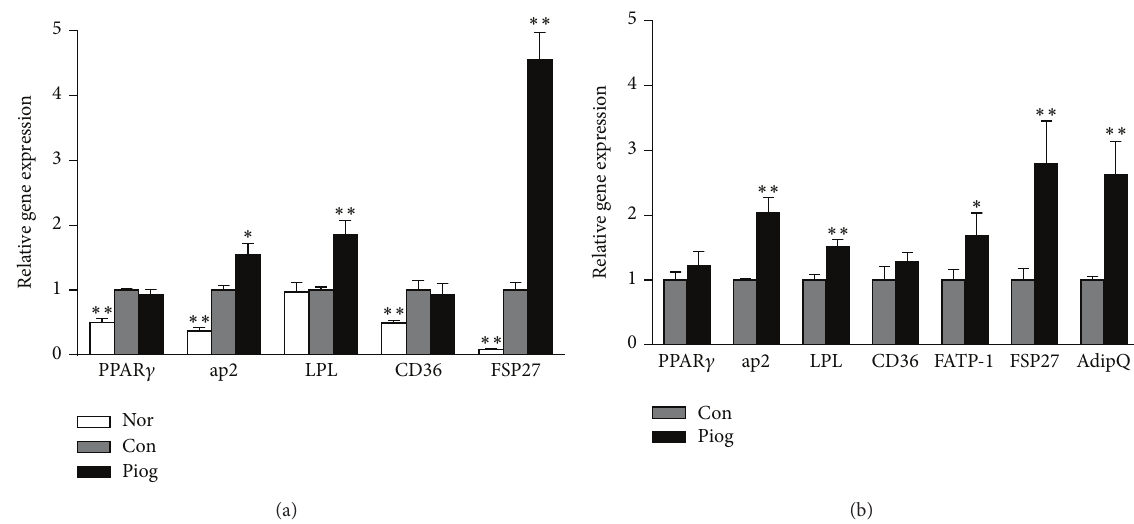
Figure 4: Expression of adipocyte-specific genes in the liver and WAT of vehicle- and pioglitazone-treated KKAy mice. Gene expression in liver (a) and WAT (b), which was examined by using the real-time PCR. Results were expressed as fold change, after correction for 𝛽 -actin levels, relative to the control mice. Nor, C57BL/6J mice; Con, vehicle-treated KKAy mice; Piog, pioglitazone-treated KKAy mice. Data are presented as mean ± S.E.M. ( 𝑛 = 6 –8 per group). ∗ 𝑃 < 0.05 , ∗∗ 𝑃 < 0.01 versus Con. PPAR 𝛾 , peroxisome proliferator activated receptor gamma; FABP4/ap2, adipocyte fatty acid binding protein 4; LPL, lipoprotein lipase; FAT/CD36, fatty acid translocase/CD36 antigen; FSP27, fat specific protein 27; AdipoQ,